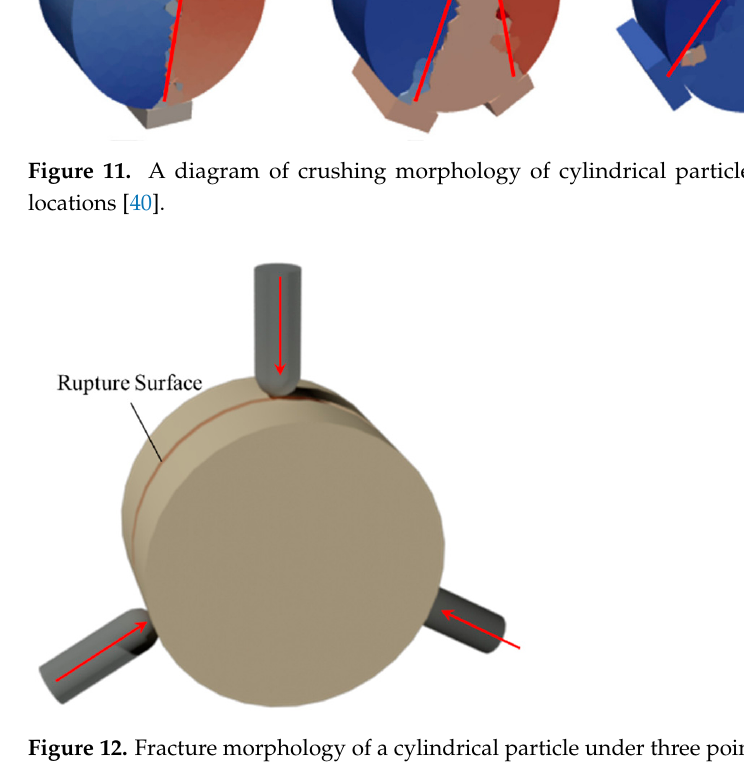
Figure 11. A diagram of crushing morphology of cylindrical particles under different contact loca-